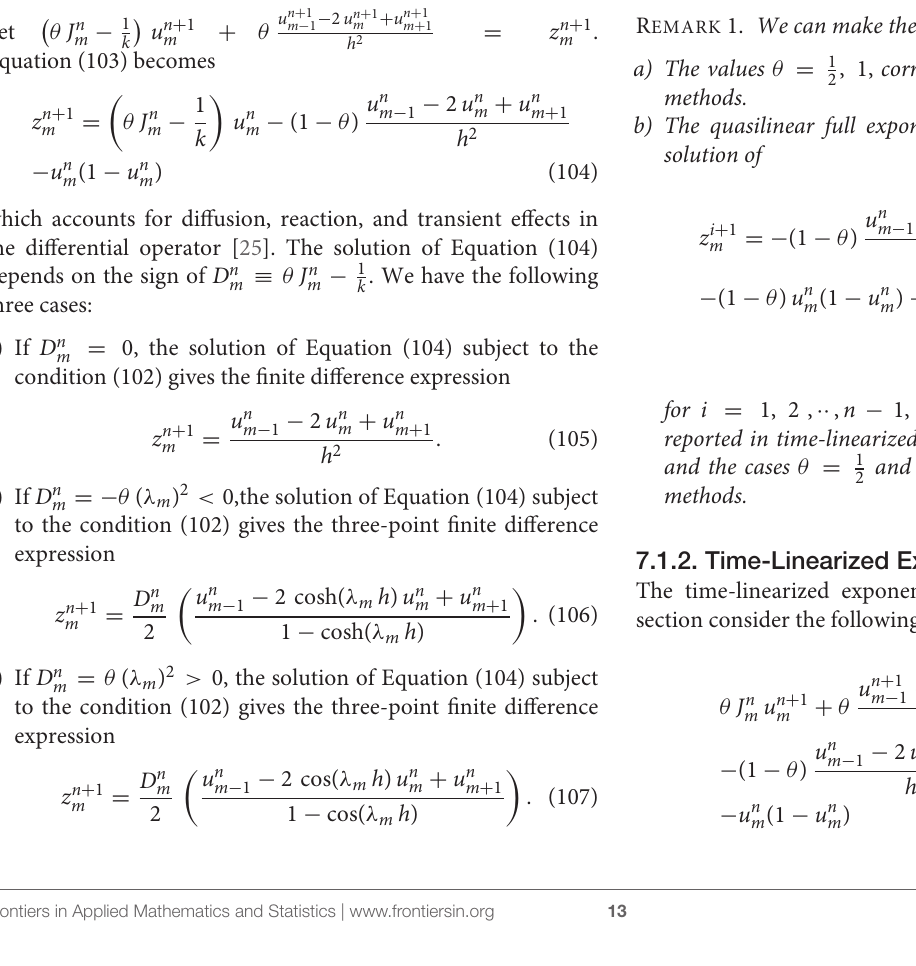
2.5 10 − 3 with spatial mesh size, h = ×